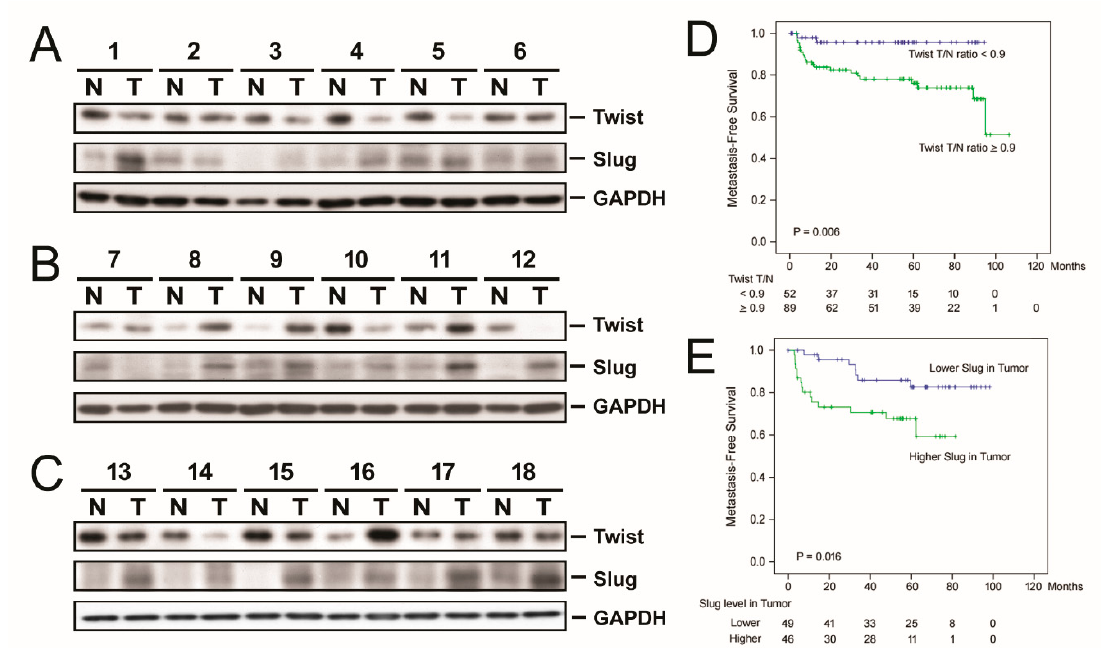
Figure 5. Association between the expression levels of epithelial-mesenchymal transition (EMT) markers, Twist1 and Slug, and postoperative outcomes in patients with HBV-related HCC. ( A – C ) Representative Western blots for an assessment of Twist1 and Slug expression levels in tissue samples derived from HCC patients. Densitometry was used for quantification. ( D ) Comparison of extrahepatic metastasis free survival (EMFS) between patients with high and low tumor/non-tumor (T/N) ratios of Twist1. Please find the western blot in Supplementary Files. ( E ) Comparison of EMFS between patients with high and low slug expression in cancerous tissues. The Kaplan-Meier analysis was performed. The cutoff of Twist T/N ratio (0.9) was determined by the minimal p -value approach [36].